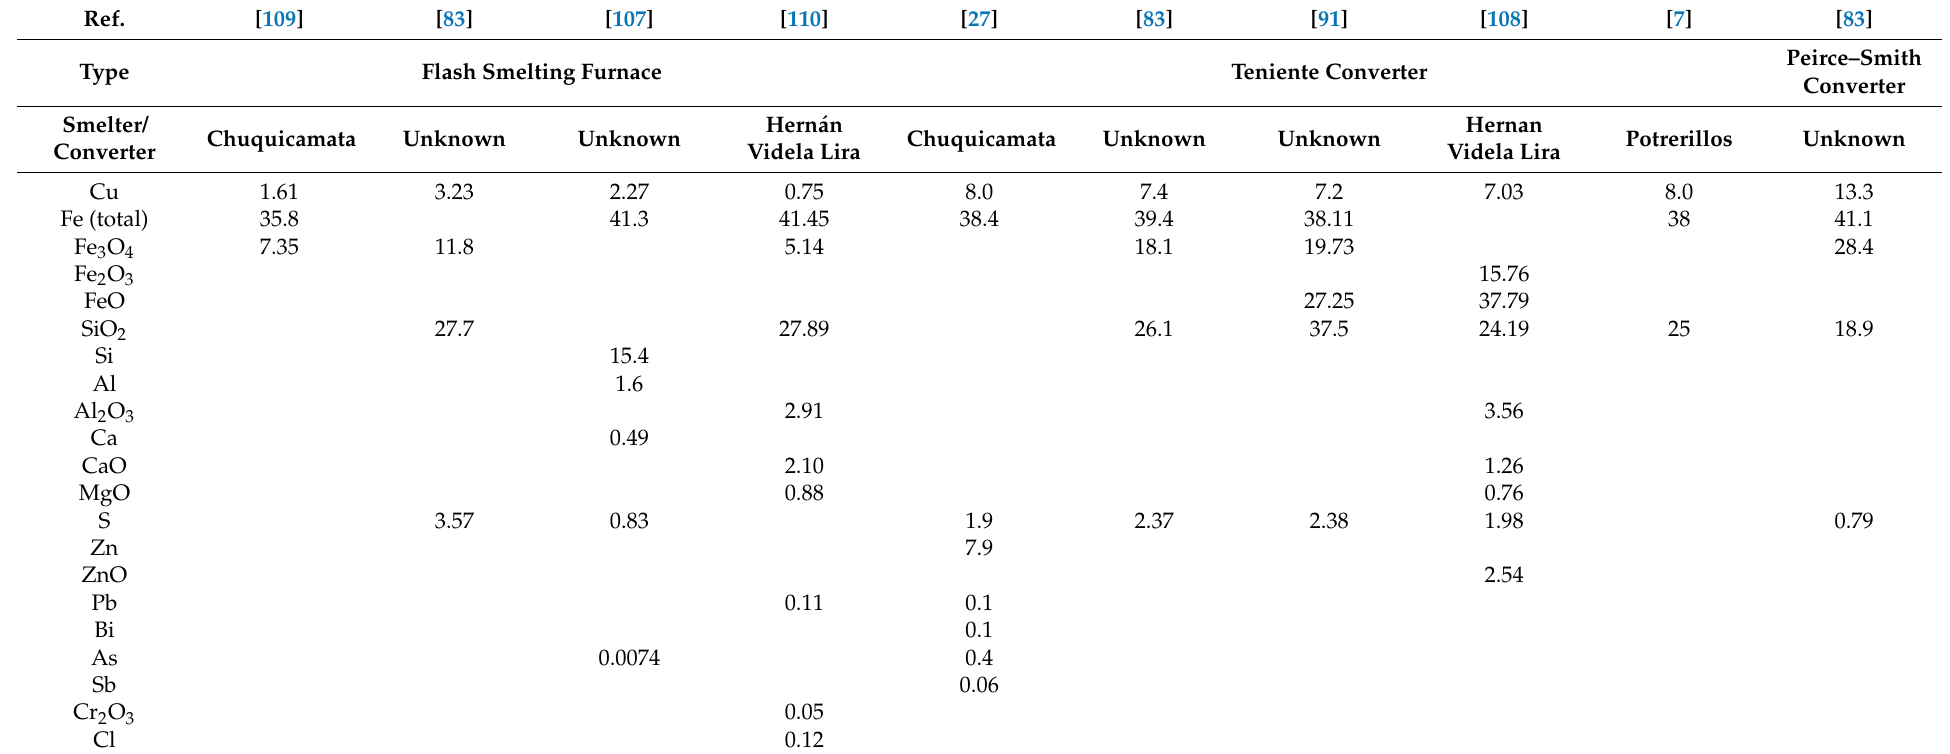
Table 8. Chemical composition (%) of slags from Chilean